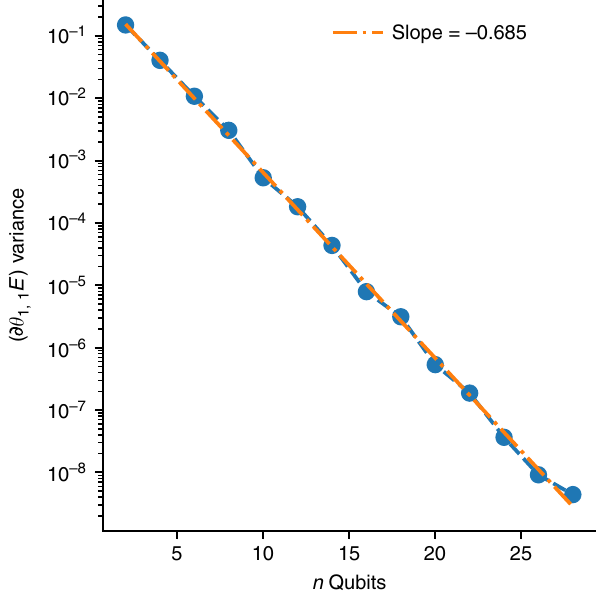
Fig. 4 Convergence to 2-design limit. Here we show the sample variance of (cid:7) (cid:8) the gradient of the energy for the fi rst circuit component of a two-local (cid:7) (cid:8) E 1 ; 1 E Pauli term ∂ θ plotted as a function of the number of layers, L , in a 1D 1 ; 1 quantum circuit. The different lines correspond to all even numbers of qubits between 2 and 24, with 2 qubits being the top line, and the rest being ordered by qubit number. The dotted black lines depict the 2-design asymptotes for this Hamiltonian as determined by our analytic results. This shows the convergence of the second moment as a function of the number of layers to a fi xed value determined by the number of